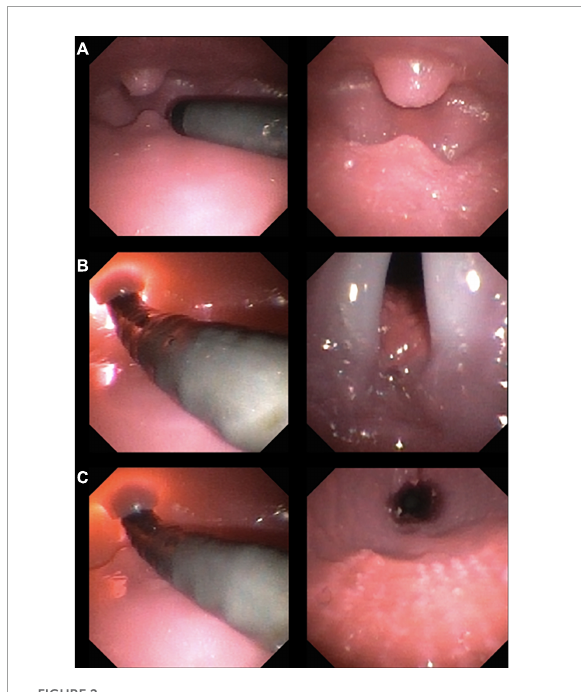
FIGURE2 Flexible video bronchoscope route through the airway of a VLBW-infant simulator.The left side shows the lateral view of the bronchoscope, the right side the view through the bronchoscope. (A) The bronchoscope enters the mouth with the uvula and epiglottis visible at the "bottom" and "top", respectively. (B) The bronchoscope is angulated behind the epiglottis until the larynx comes into sight. (C) Finally, the bronchoscope is inserted through the glottis into the